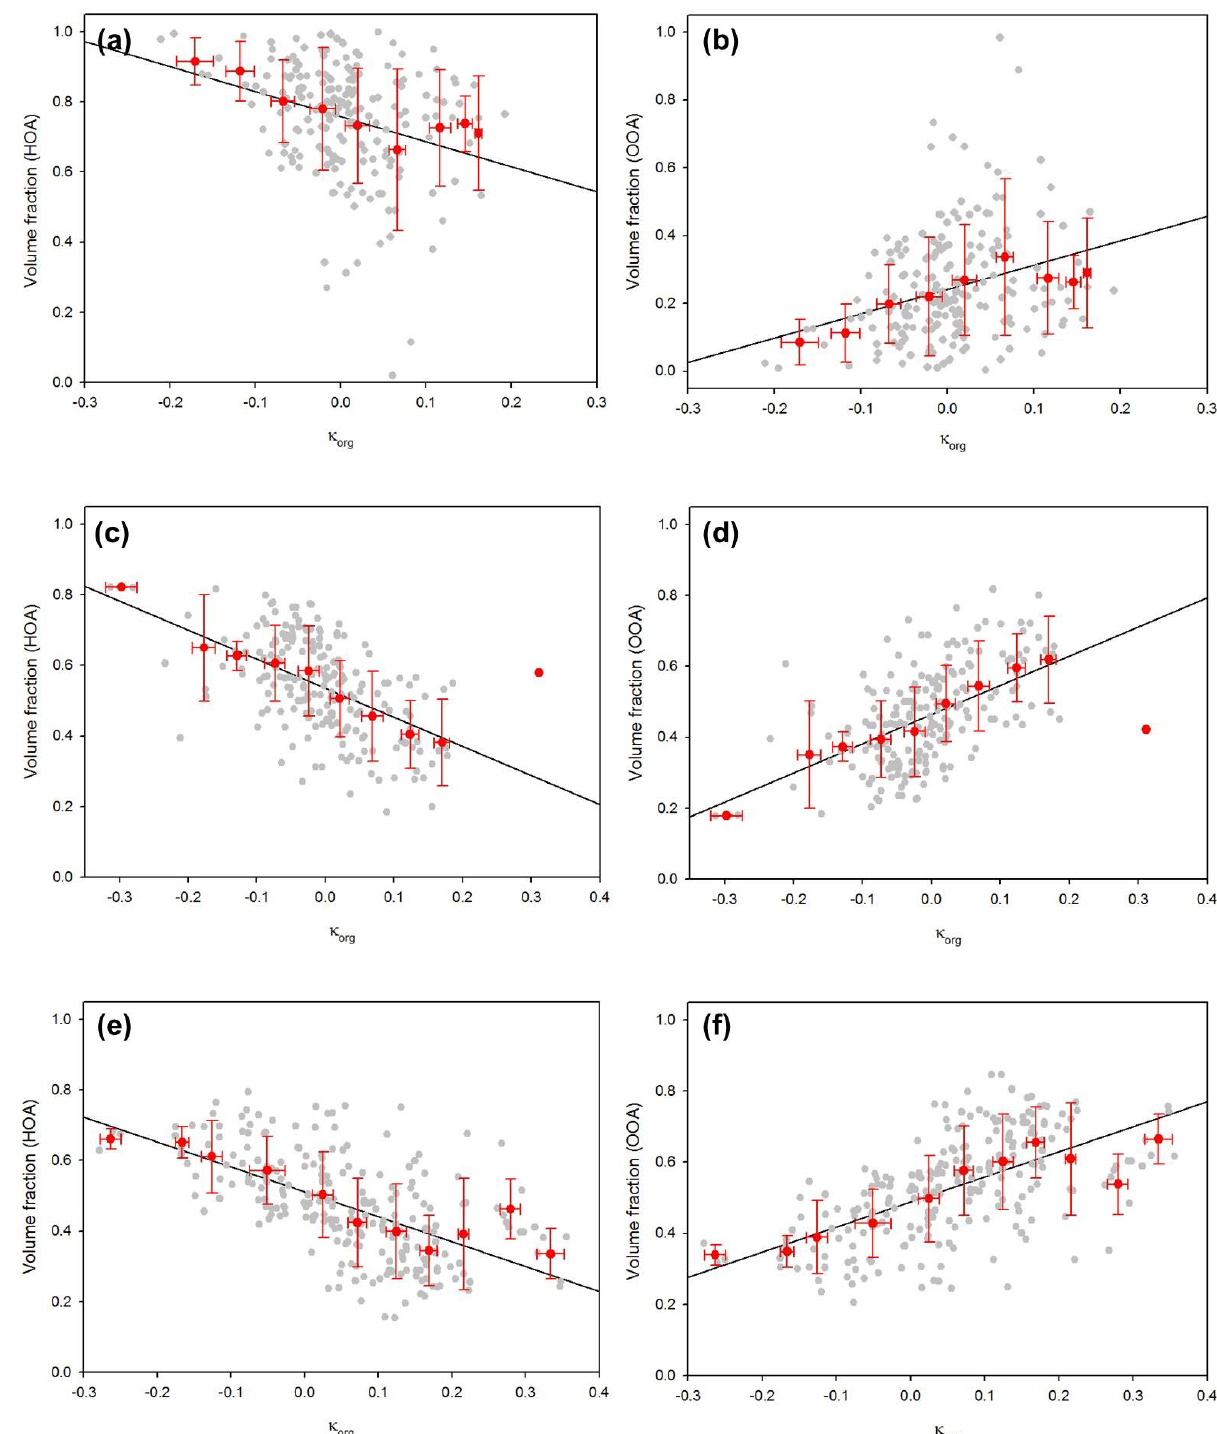
Figure 9. Scatterplot of κ org vs. volume fraction of HOA (a, c, e) and OOA (b, d, f) among organics for 50nm (a, b) , 100nm (c, d) , and 150nm (e, f) dry diameters. κ org is calculated as follows: κ org = (κ HTMDA − ε inorg κ inorg )/ε org , where ε indicates the volume fraction of each